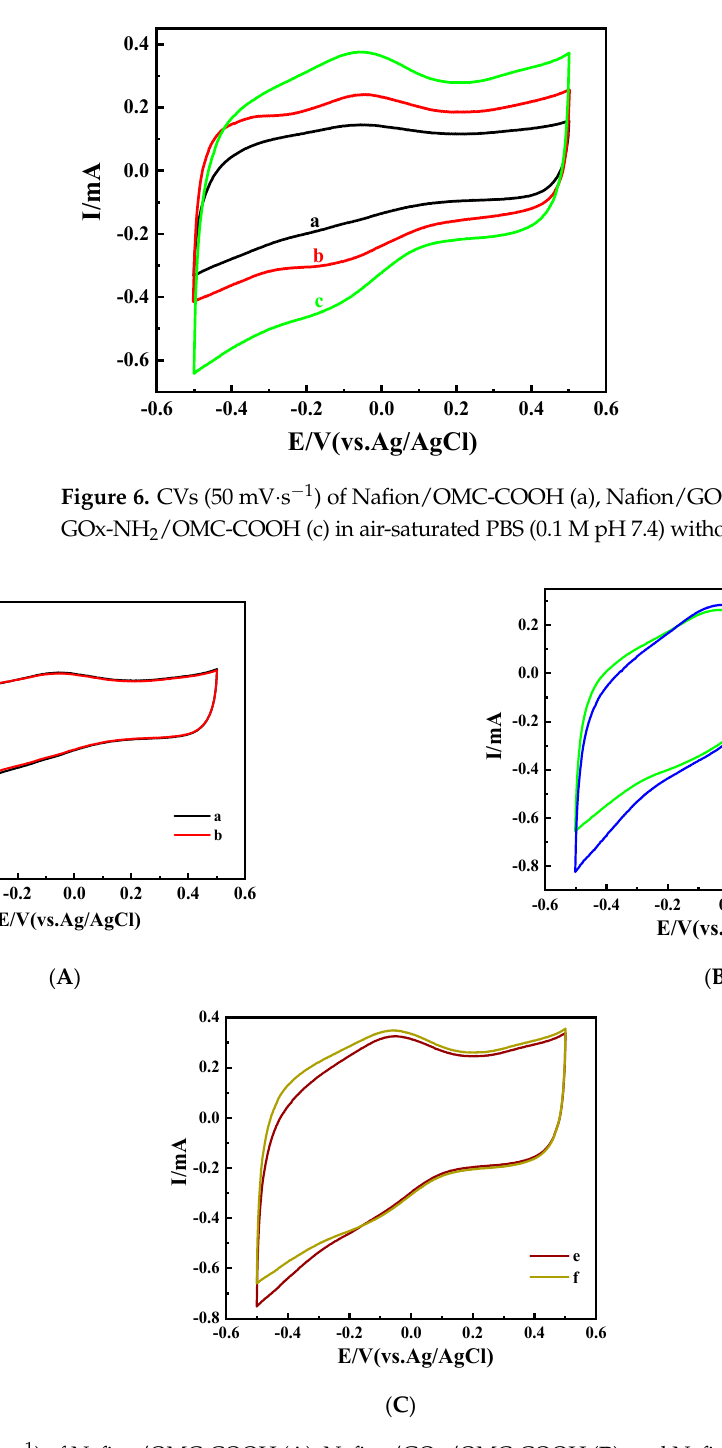
Figure 7. CVs (50 mV·s − 1 ) of Nafion/OMC-COOH ( A ), Nafion/GOx/OMC-COOH ( B ), and Nafion/GOx-NH 2 /OMC-COOH ( C ) in air-saturated PBS 0.1 M pH 7.4 without (a,c,e, respectively)/with (b,d,f, respectively) the addition of 20 mM glucose. The CVs of Nafion/GOx/OMC-COOH and Nafion/GOx-NH 2 /OMC-COOH at dif- ferent scan rates (20–150 mV · s − 1 ) in PBS buffer are also shown in Figure 8. The anodic and cathodic peak currents of the Nafion/GOx/OMC-COOH and Nafion/GOx-NH 2